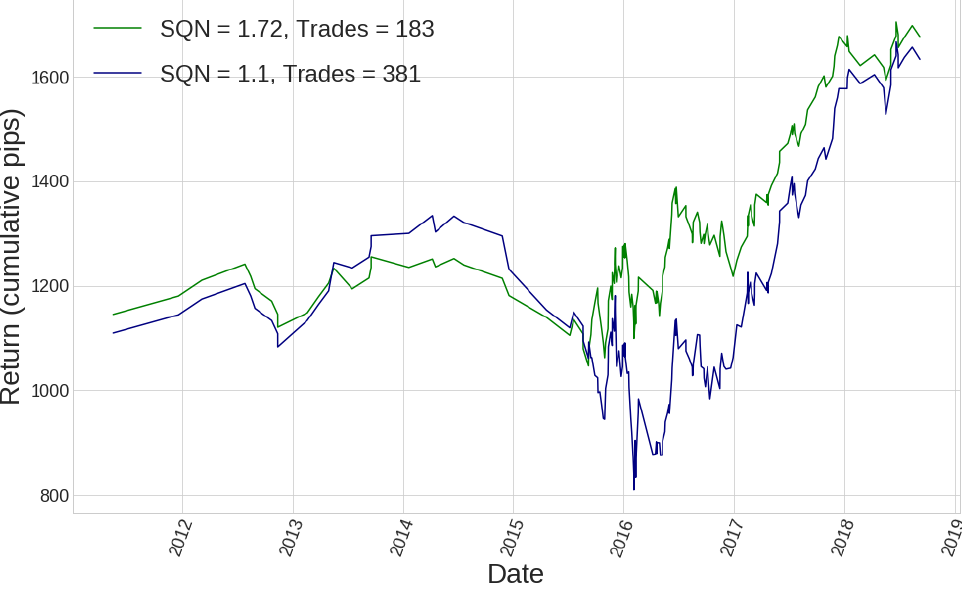
Figure 9. Blue curve shows the out of sample equity curve arising from the optimal single candlestick pattern strategy. In green, we have the equity curve of the same strategy, where a AB classifier algorithm was used to define the signal for entering the market on the same training data used by the single candlestick pattern